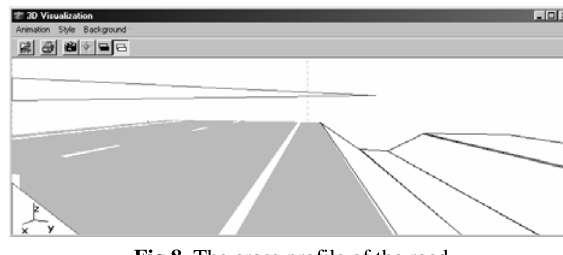
Fig 8. The cross profile of the road